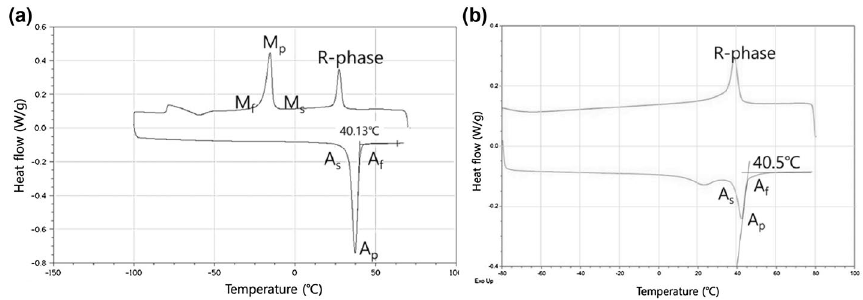
Fig. 5 DSC results of the shape memory alloy wire of diameter 0.3 mm ( a ) and 0.5 mm ( b